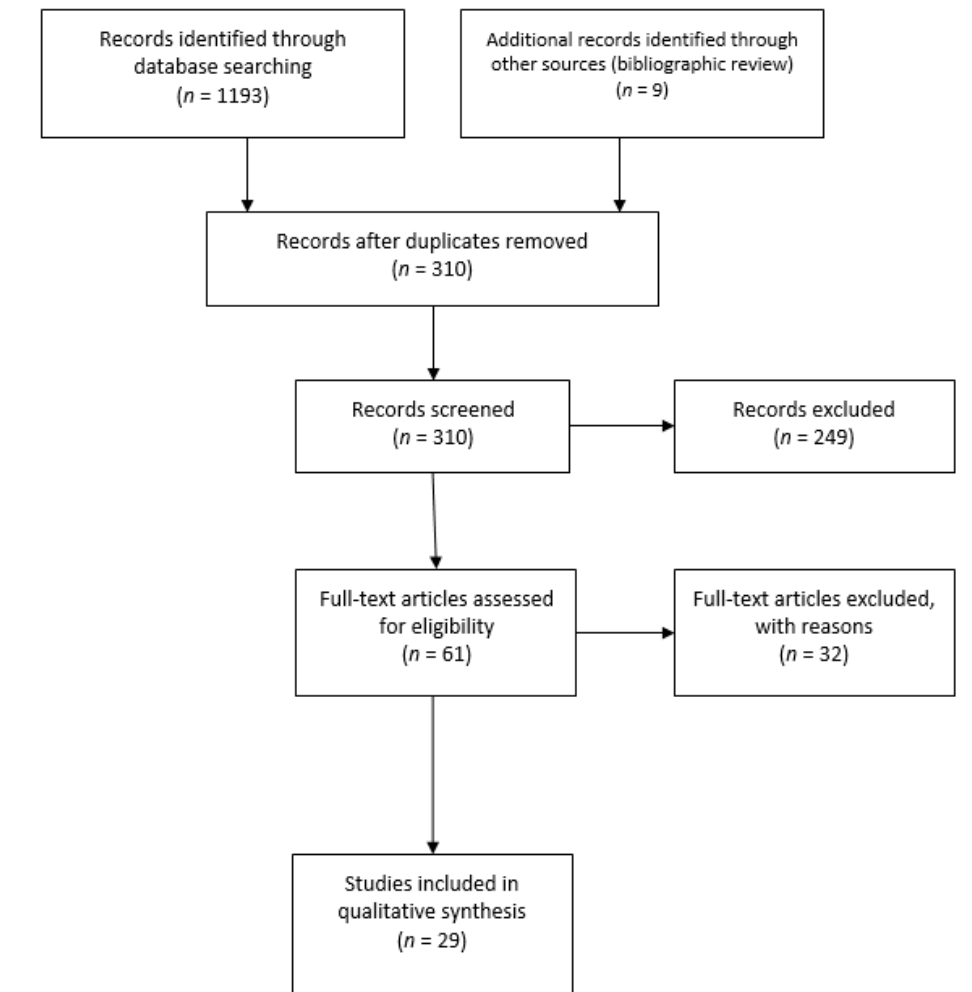
Figure 1. PRISMA flowchart of article identification and exclusion. Table 1. Study design and outcomes reported.